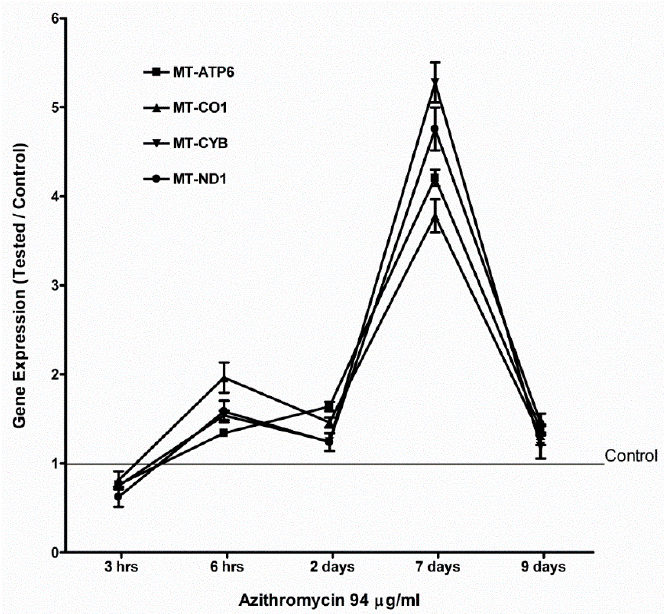
Figure 4. Azithromycin upregulated gene expression of mitochondrial OXPHOS enzymes in MCF-12A cells. MT-ATP6 : mitochondrially encoded ATP synthase 6; MT-CO1 : mitochondrially encoded